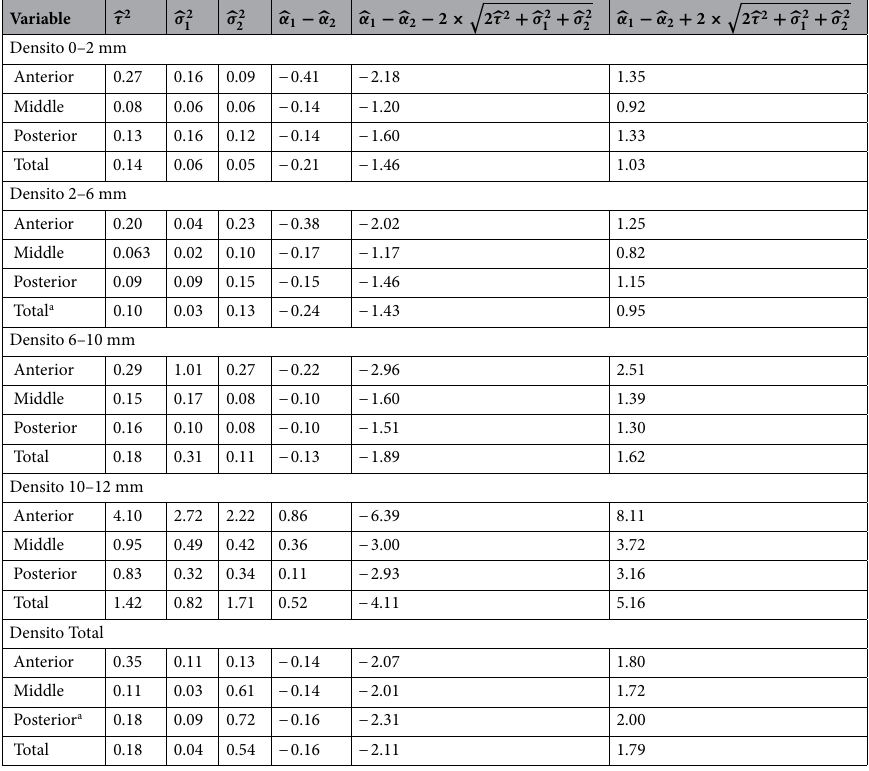
Table 4. Prediction limits for differences between single measurements in healthy controls. The values are in GSU (Gray Scale